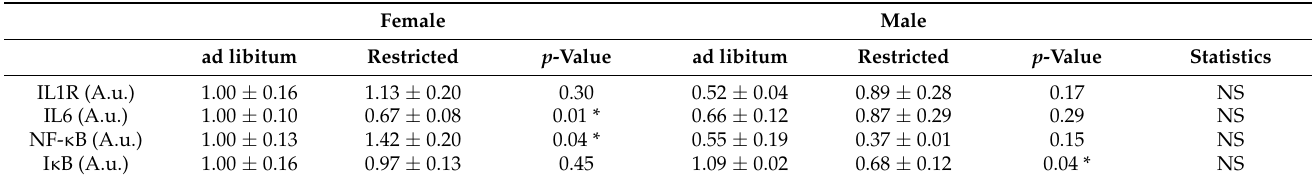
Table 10. Protein levels of several inflammation-related pathways markers analyzed by Western Blot. Two-way ANOVA was performed to assess for significance. NS: non-significant. * Statistical differences between calorie restricted and control groups. All data were normalized to ad libitum females.